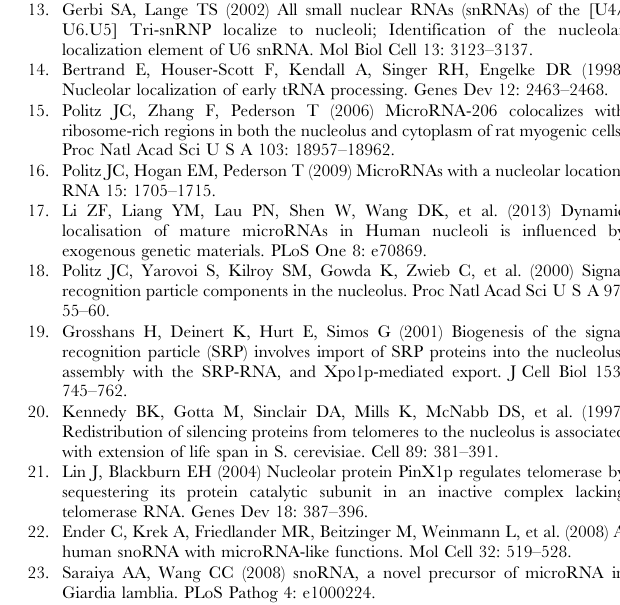
Figure S1 Select small RNA reads. (TIF) Figure S2 Northern analysis of SNORD44 following LMB-treatment. Cells were treated with leptomycin B (LMB) (10 m M) for 3 hours, fractionated and RNA was isolated. RNA (25 m g) was separated on 15% gel and hybridized to SNORD44 5 9 probe. Relative expression of the SNORD44 forms in the nucleolar fraction is shown below. (TIF) Figure S3 Long exposure of Northern hybridization in Figure 7F. (TIF) Table S1 Frequency of all snoRNA reads in the subcel- lular